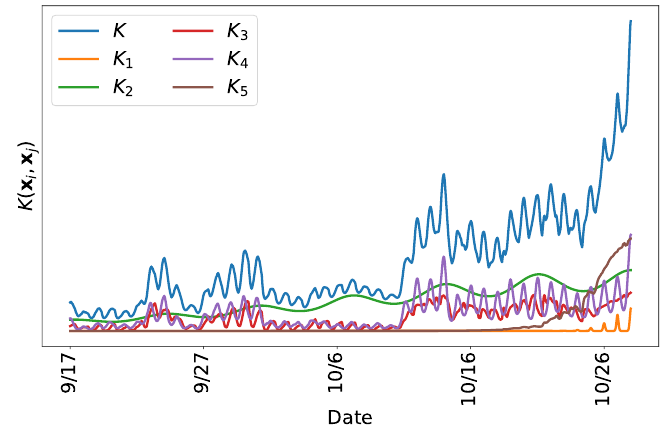
Figure 14. Values for the first row of K ( X new , X ) , and for all of its constituent